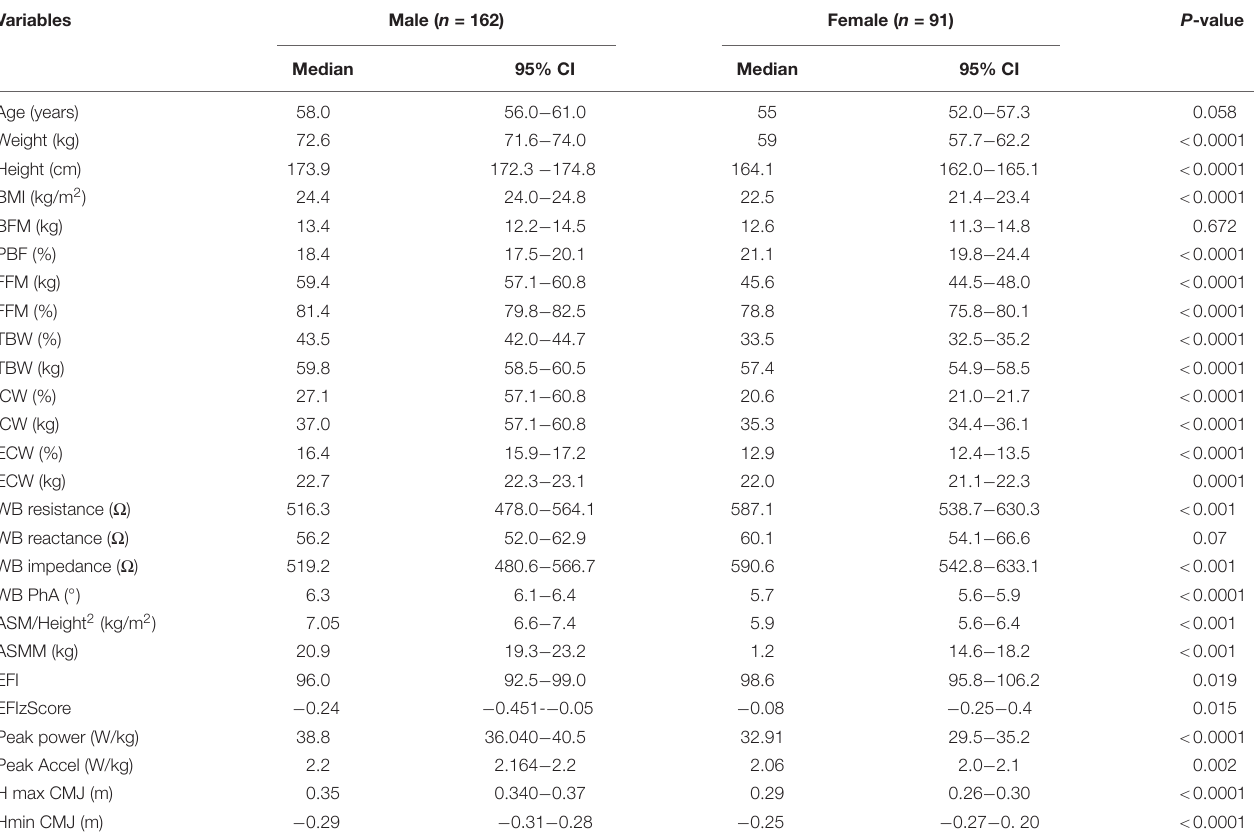
TABLE 1 | Comparisons of body composition and vertical jump performance between male and female masters athletes.